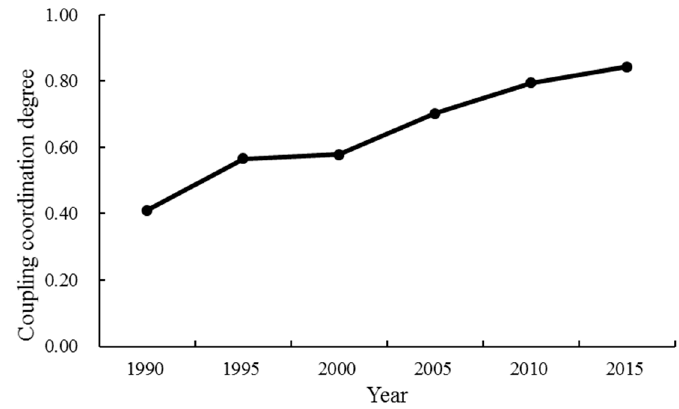
Figure 9. The coupling coordination degree among the production-living-ecology land use functions in the Beijing-Tianjin-Hebei region (1990–2015).